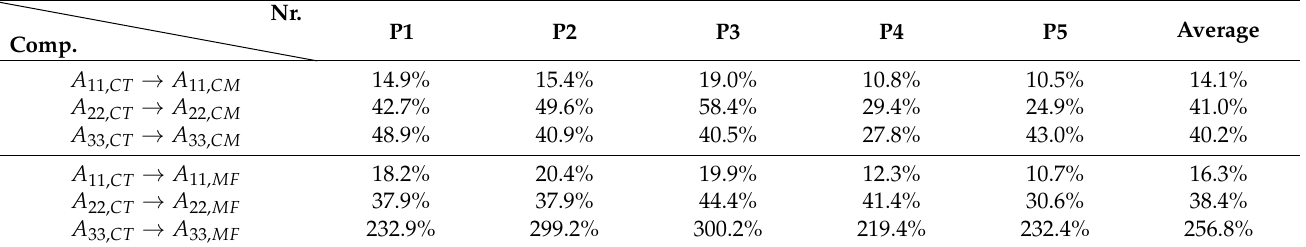
C NC ,2 and C OC ,2 for the material PPAGF50 at the component level. The CT results of 0, MF 0, CM